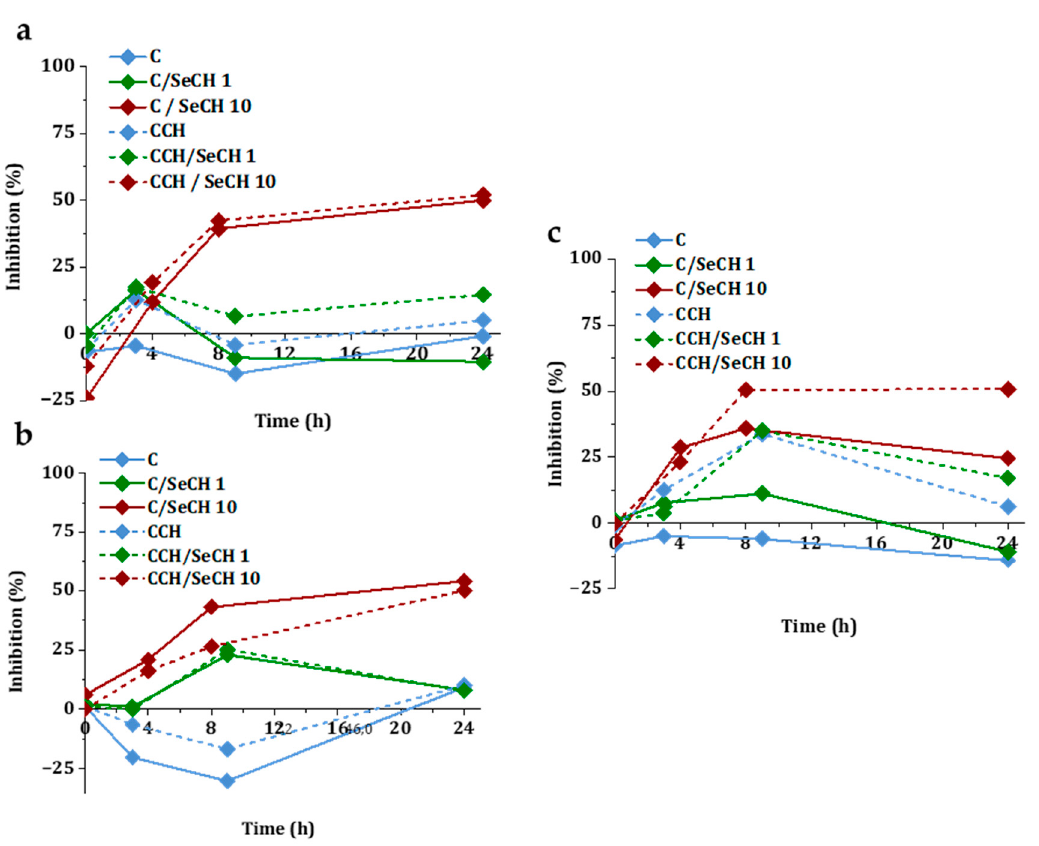
Figure 10. Time-dependent bacterial inhibitory curves for S. aureus ( a ), MRSA ( b ), and E. coli ( c ). Bacterial samples were incubated in media with pure scaffolds and scaffolds of Se concentrations of 1 ppm or 10 ppm.